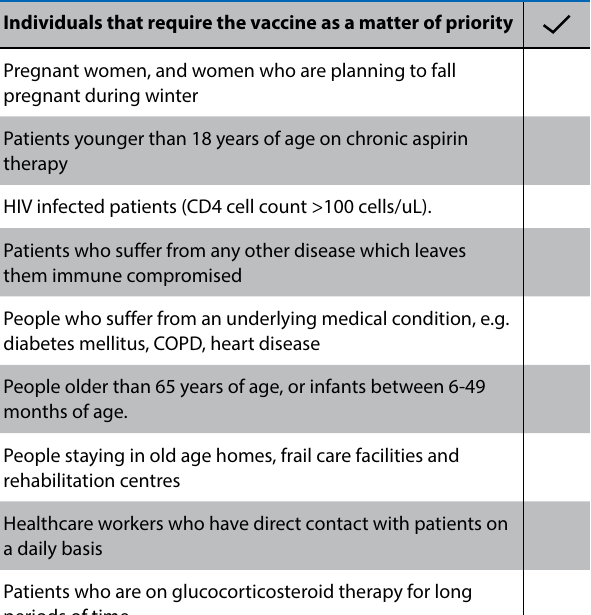
Figure 2: Adverse effects of flu vaccines 12, 13, 14